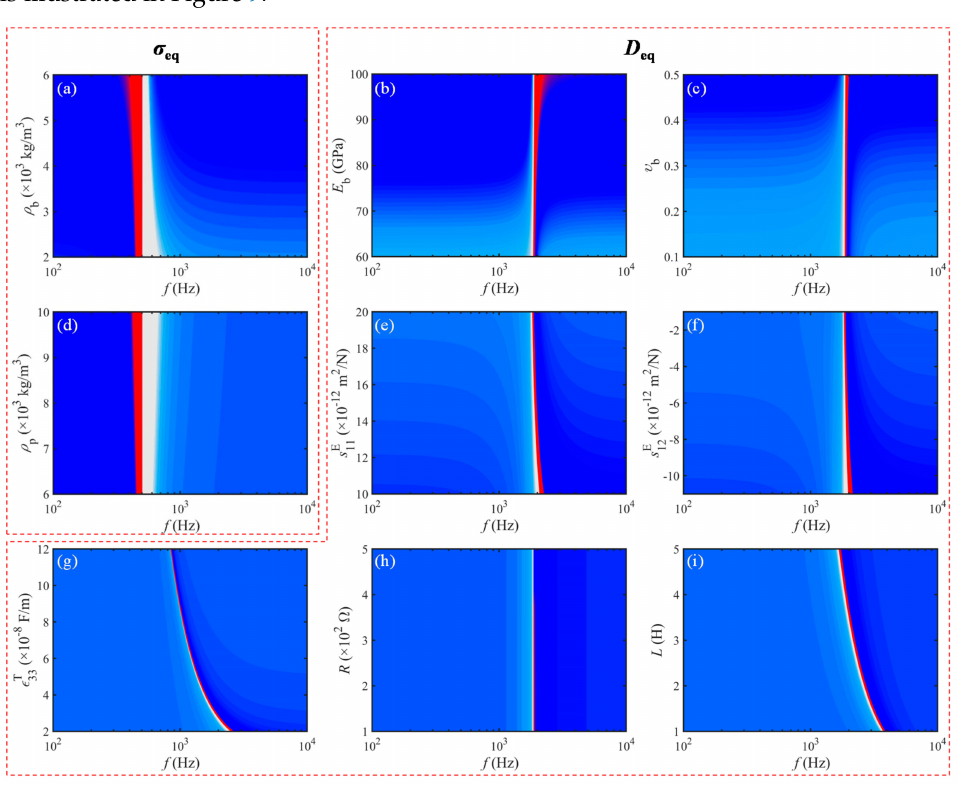
Figure 9. Dual equivalent properties vary with material parameters: ( a ) ρ b , ( b ) E b , ( c ) υ b , ( d ) ρ p , ( e ) s E , ( f ) s E , ( g ) ε T , ( h ) R , and ( i ) L 33 11 12